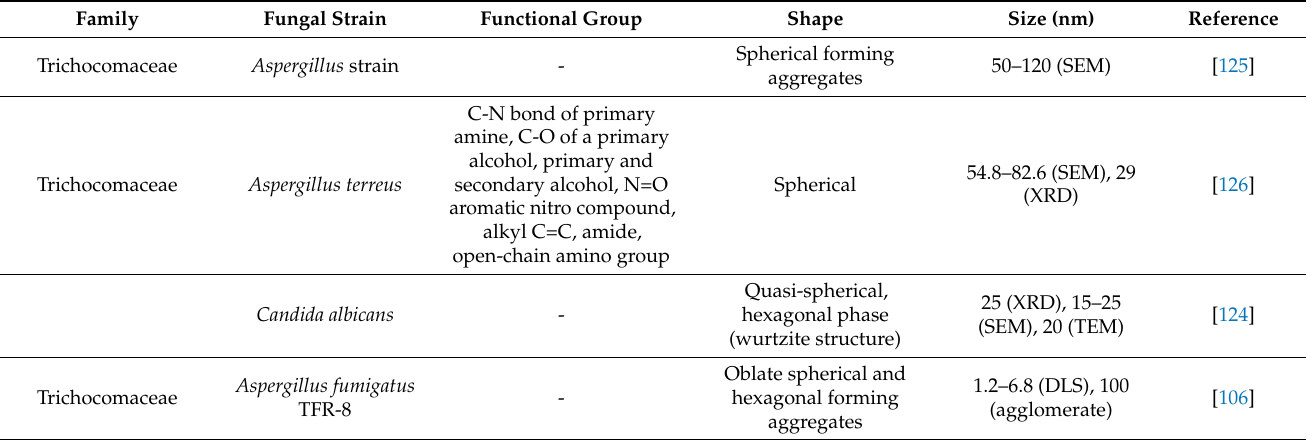
Table 4. Synthesis of ZnO NPs using fungi.